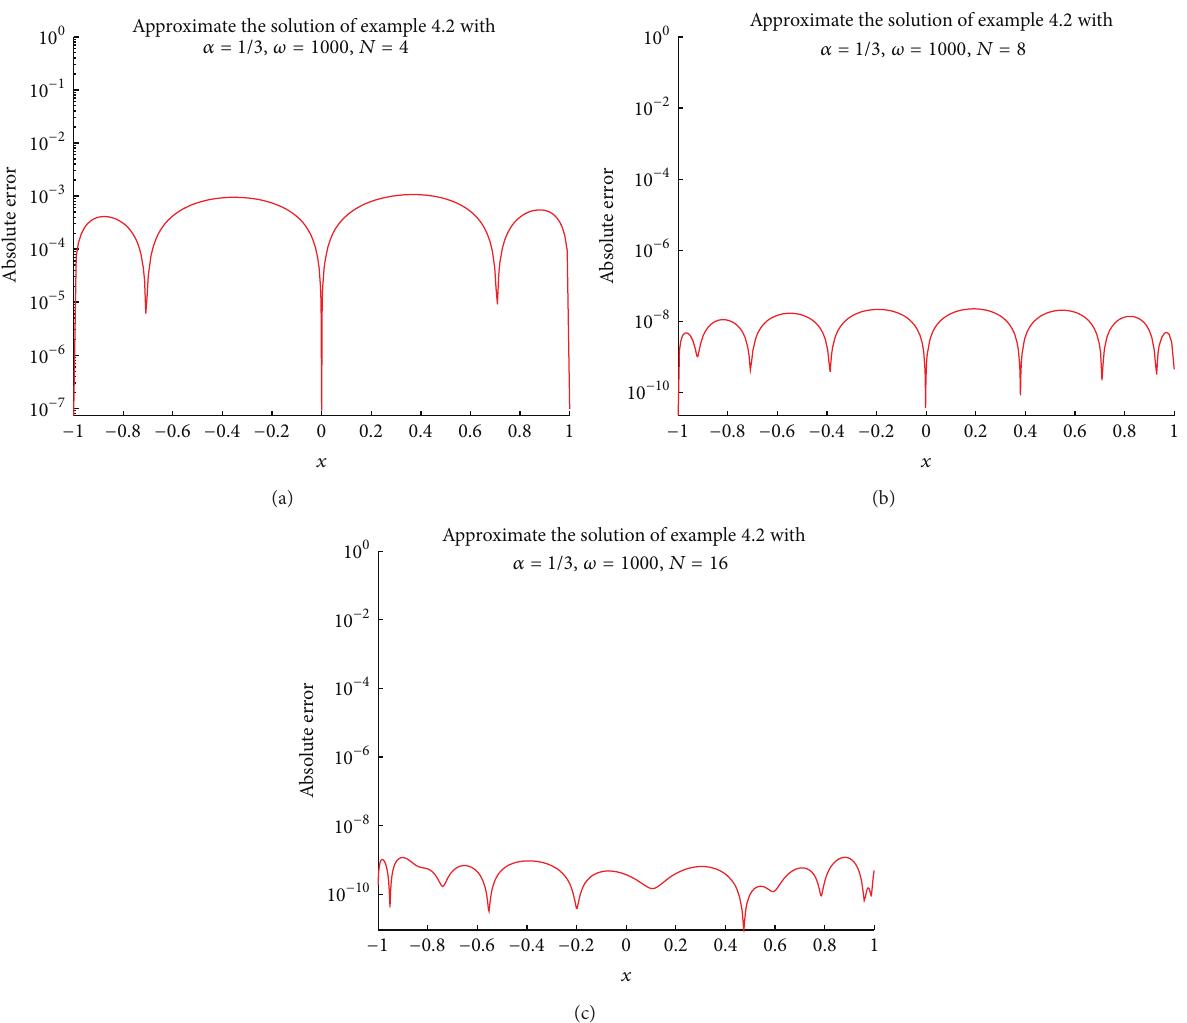
Figure 2: Example 2: the absolute error versus the 𝑥 -coordinate for 𝑁 = 4 (a), 𝑁 = 8 (b), and 𝑁 = 16 (c) with negative data ignored.